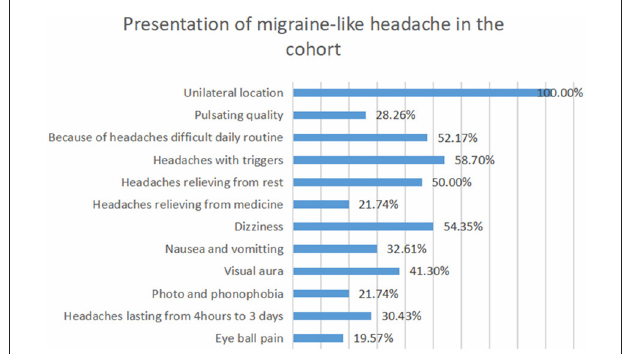
FIGURE 1 | Presentation of migraine-like headache in the cohort.